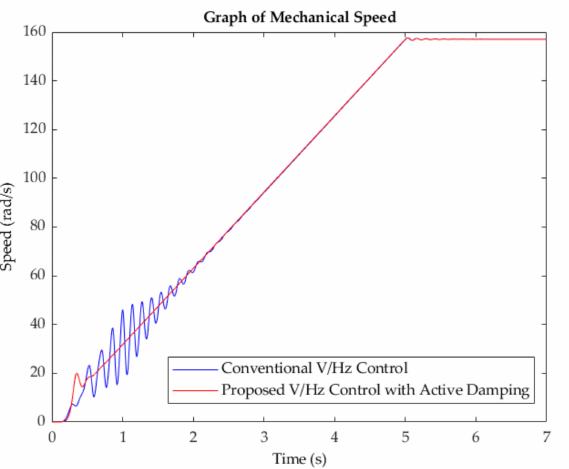
Figure 15. Mechanical speed—active damping technique (red) vs. conventional V/Hz